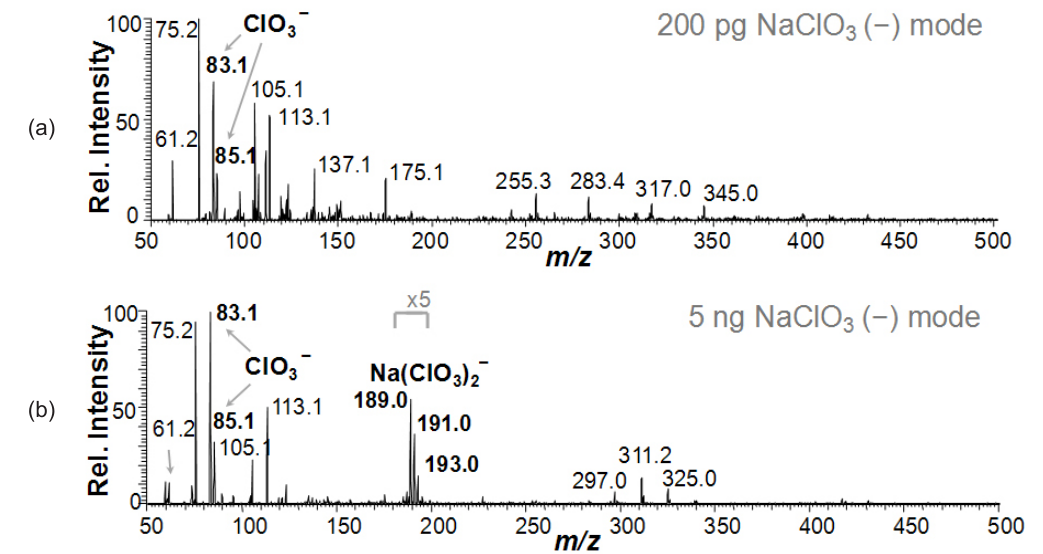
Figure 1. DESI mass spectra of (a) 200 pg sodium chlorate deposited on porous PTFE surface; (b) 5 ng sodium chlorate deposited on nonporous PTFE surface. Ions of m/z 59.2, 61.2 and 75.2 (±0.1) are interpreted here as originating from trace solvent impurities. They are commonly observed during negative ion mode DESI-MS analysis of salts deposited on various surfaces. Ions of m/z 105, 113, 137, 175, 255, 283, 317, 345 are interpreted as due to the trace impurities either originally present on the substrate or brought to the surface during sample